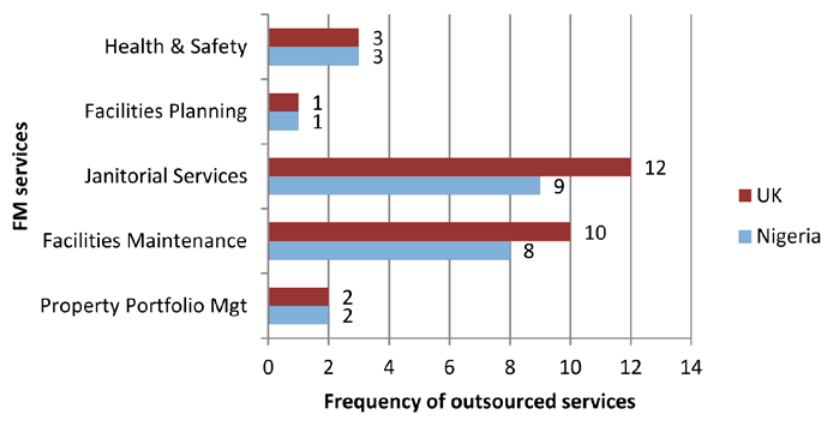
Fig. 3. Result of response on outsourced FM Table 3. Result of analysis for motives for outsourcing